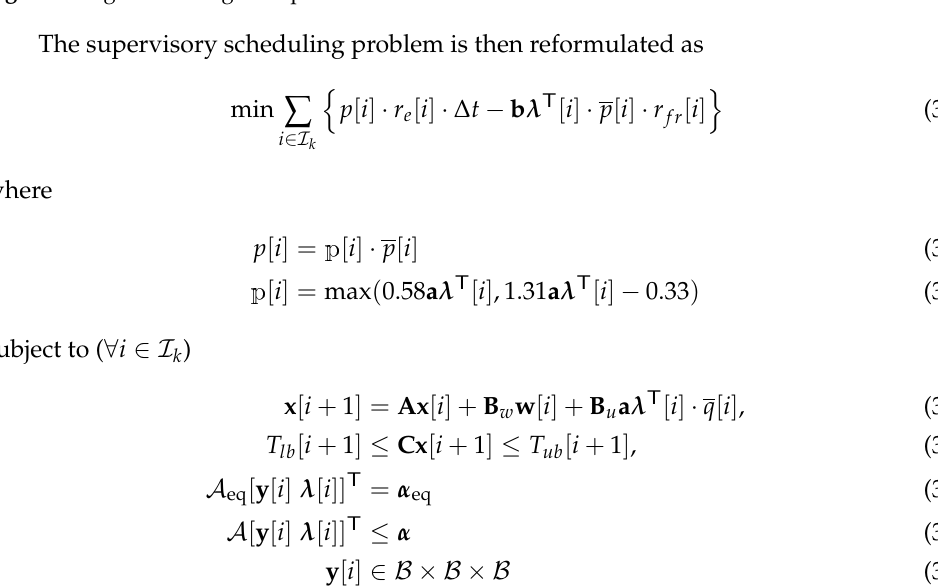
Figure 7. A general 3-segment piece-wise linear